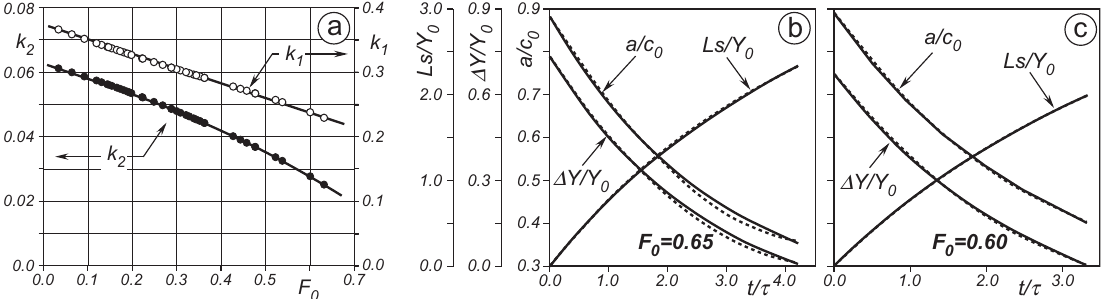
Figure 3. ( a ) coefficients k 1 and k 2 as they vary with F 0 (symbols denote the numerical solution of the 0D model, full lines are the approximation given by Equation (12)); ( b ) wave front velocity, a , and height, ∆ Y , and the position of the front, L , as a function of time for F 0 = 0.65 (full lines denote the numerical solution of the 0D model, dashed lines denote the analytical solution); ( c ) same as ( b ) for F 0 =